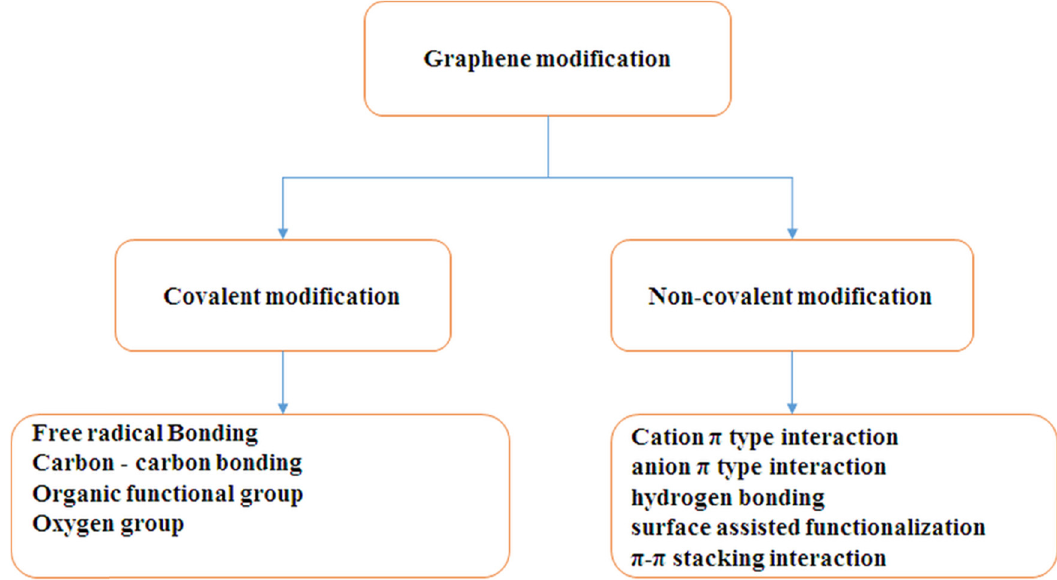
Figure 1: Classi fi cation of graphene modi fi